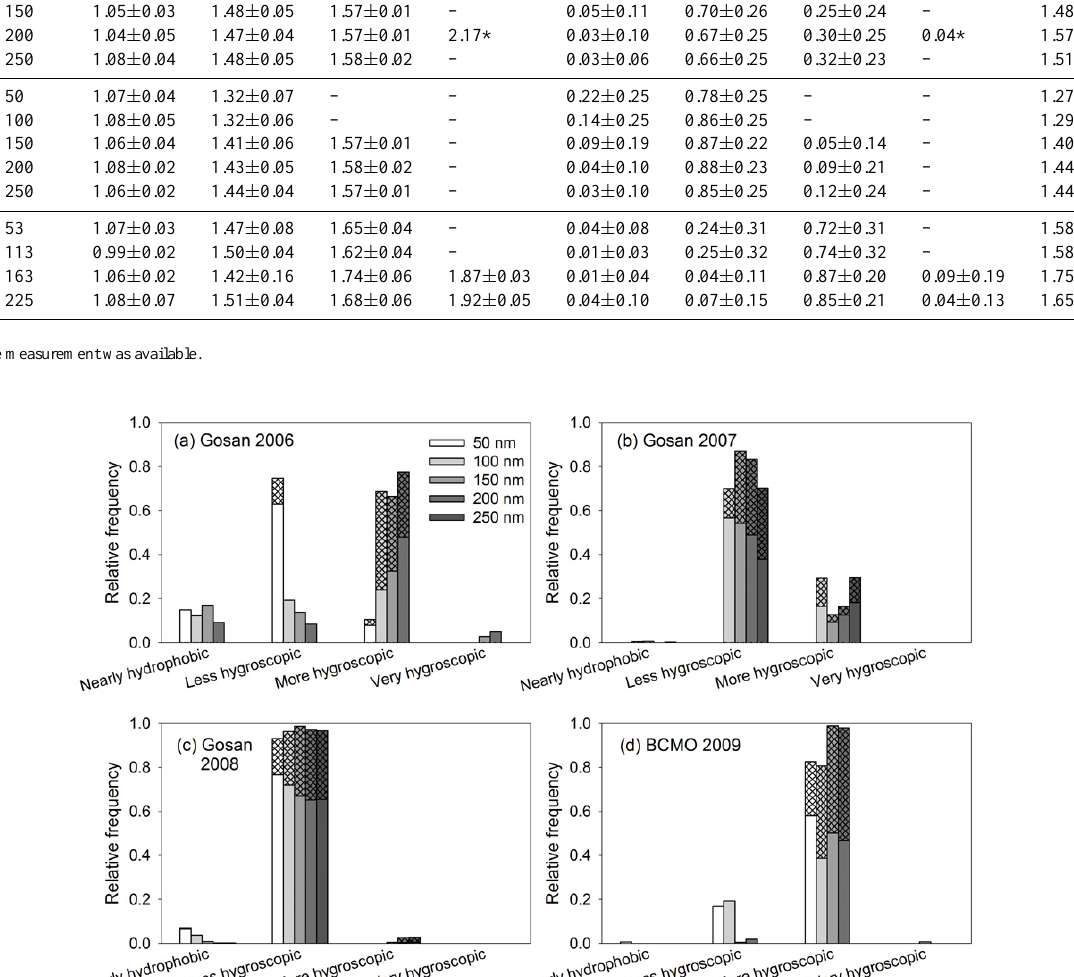
During BCMO 2009, S c values for the two monodisperse dry particle sizes were relatively larger for the periods before 13 August than after 13 August. This distinction between these periods was also found in the PM 2 . 5 and SO 2 data.